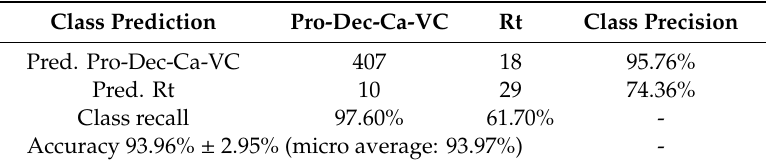
Table 4. The result of the classification—decision tree #3.